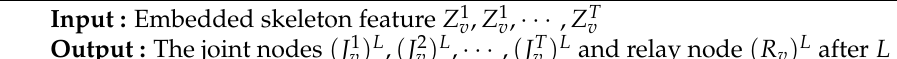
Algorithme 2 : The update of temporal relative